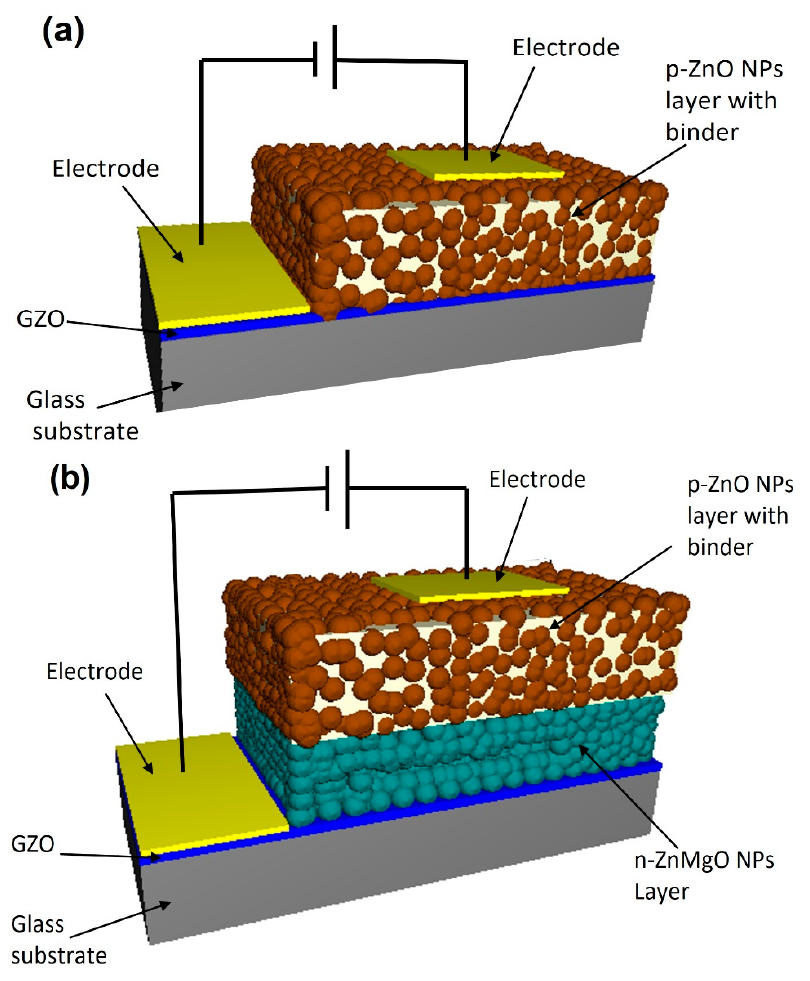
Figure 1. Schematic view of the LEDs based on ZnO NPs. ( a ) the structure of p-ZnO/GZO ( b ) the structure of p-ZnO /n-ZnMgO/GZO.